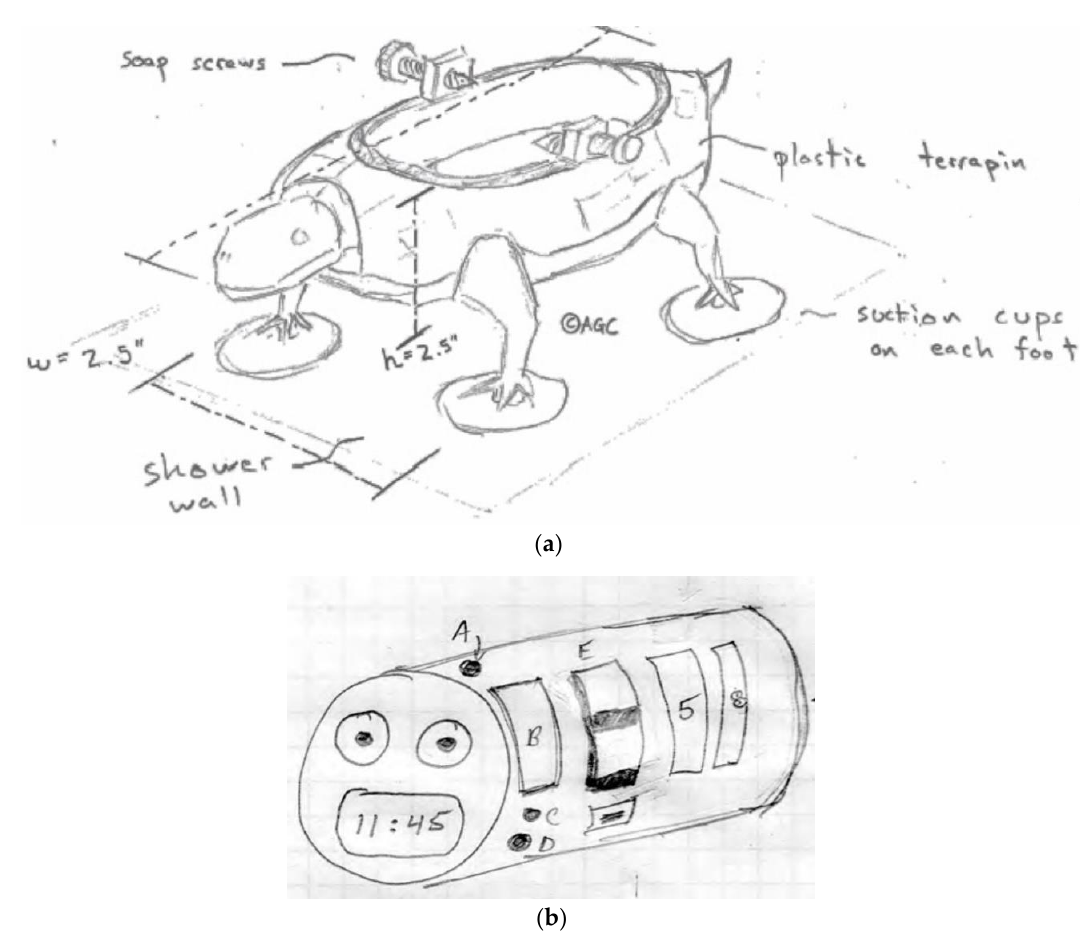
Figure 2. Excerpts from the analogy study of student work: ( a ) an example from Student 2 in the control group, and ( b ) an example from Student 12 in the experimental group.